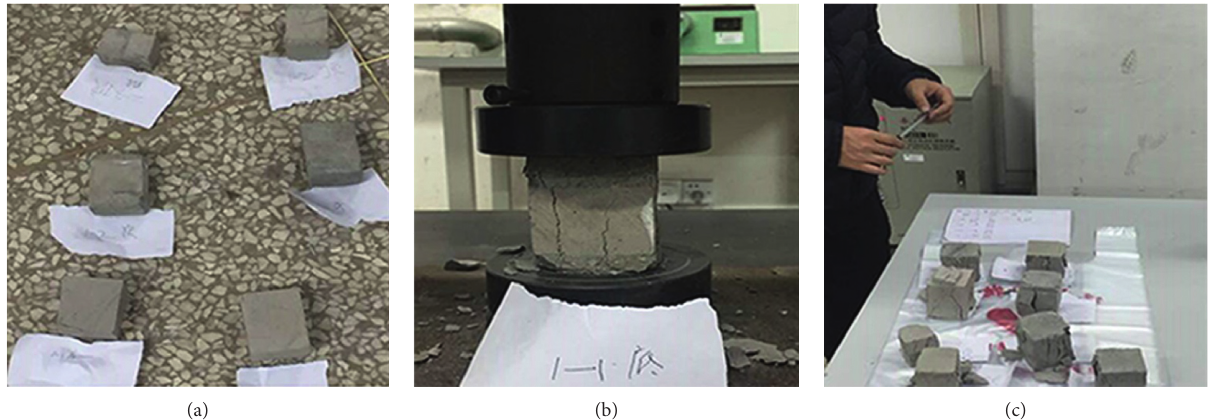
Figure 13: Uniaxial compression test. (a) Standard samples. (b) Applied pressure on samples. (c) Damaged